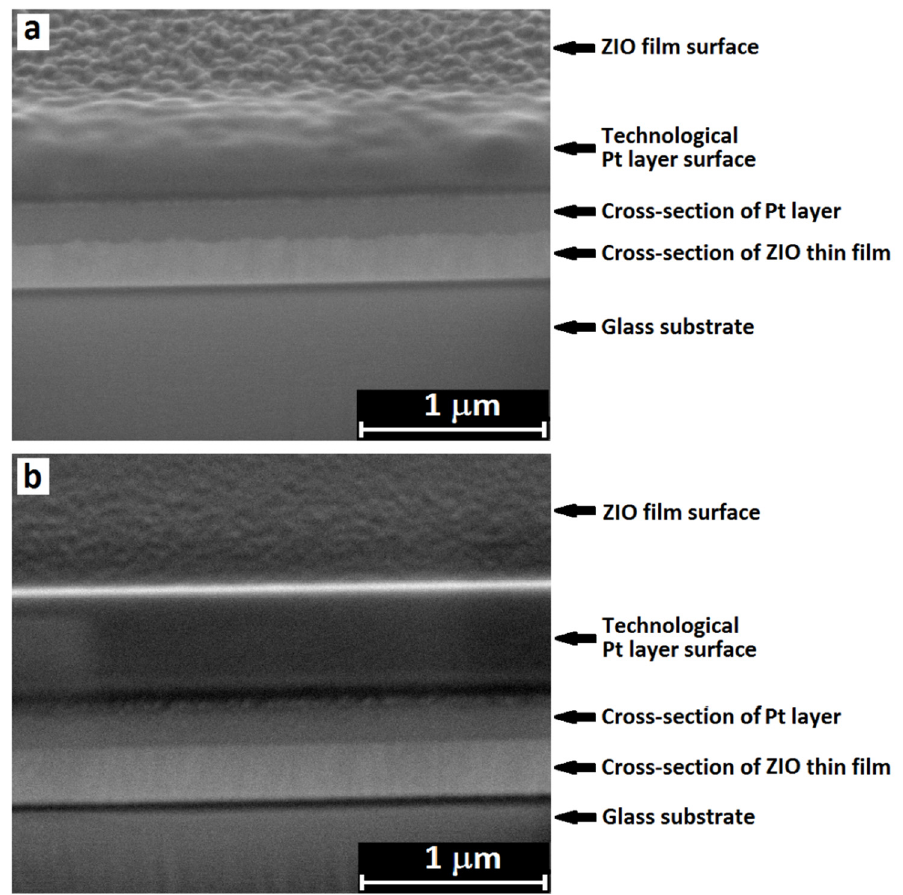
Figure 2. SEM micrographs of ZIO thin films deposited by using targets with In 2 O 3 content of 0.5 ( a ) and 5.0 mol% ( b ). To obtain an image of transverse cleavage morphology, thin-film samples were subjected to local deposition of a technological platinum layer followed by ion etching.